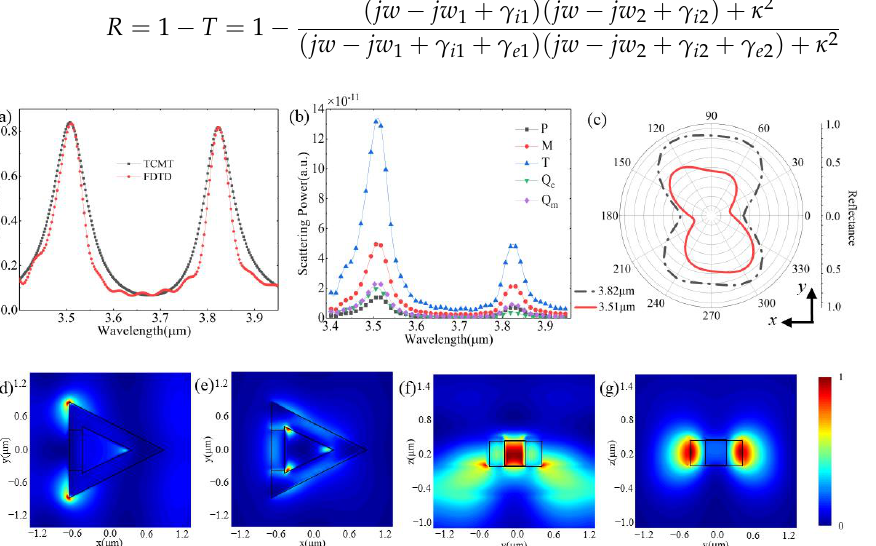
Figure 2. ( a ) Reflectance spectra of the metasurface obtained by FDTD and TCMT; ( b ) scattering powers of multipole radiating moments; ( c ) far-field distributions in X-Y plane at the wavelengths of 3.51 μm and 3.82 μm; normalized electric field intensity distributions in X-Y plane at the wavelengths of ( d ) 3.51 μm and ( e ) 3.82 μm; normalized electric field intensity distributions in Y-Z plane at the wavelengths of ( f ) 3.51 μm and ( g ) 3.82 μm.